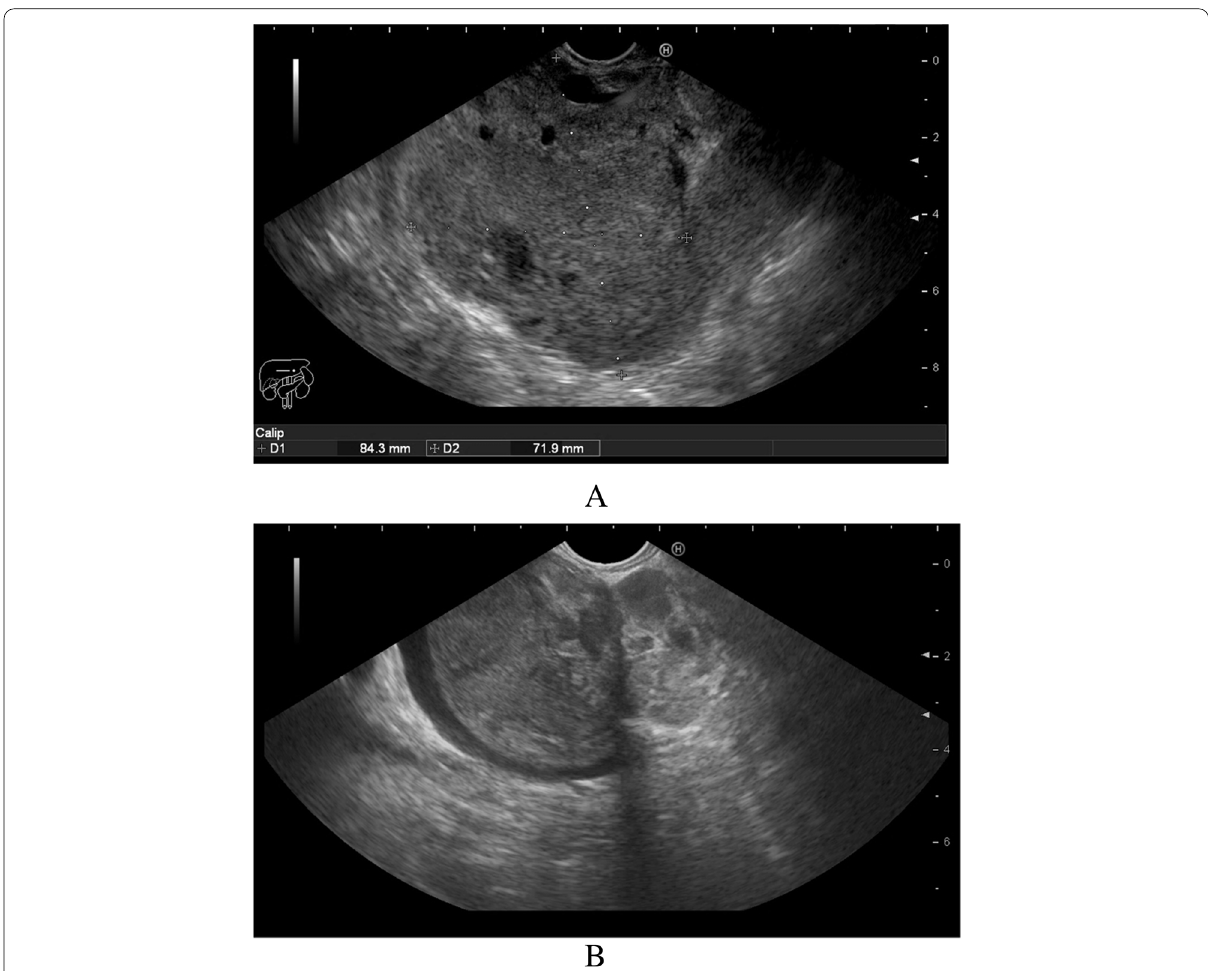
Fig. 1 EUS examination of solid‑pseudopapillary neoplasm of the pancreas. A Mass in the head of the pancreas. The mass appears to be heterogenous mass with multiple small cysts (areas of breakdown). B EUS examination of a SPPN in the body of the pancreas seen compressing the confluence of the portal vein with no encroachment (clear line of